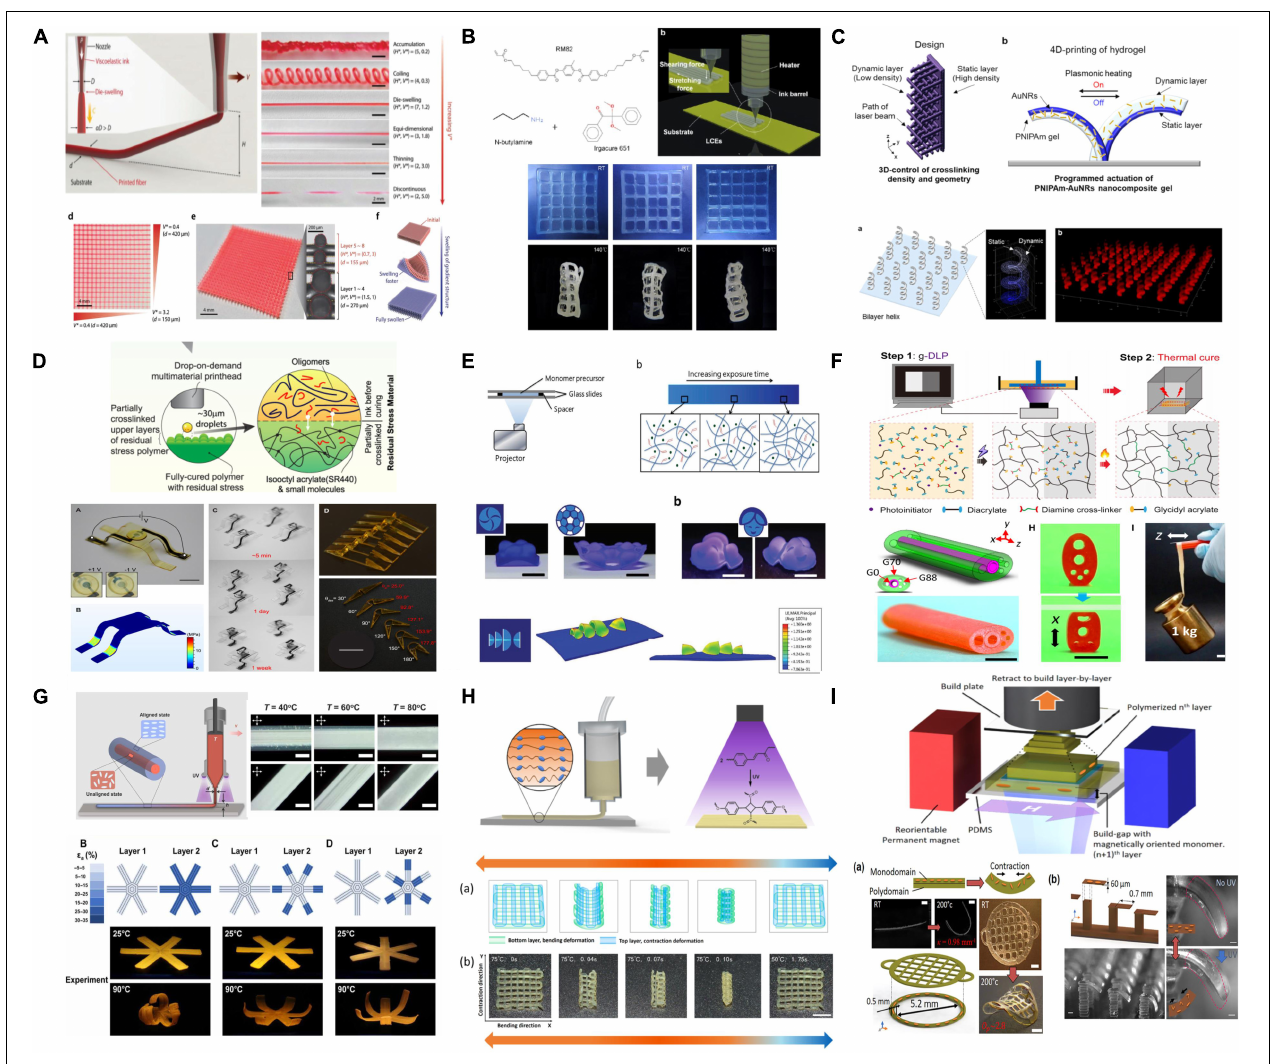
FIGURE 6 | The soft actuators mimicking the designs of plants by regulating the parameters in 4D printing process. (A) Gradient swelling soft actuator by varying the moving speed and the printing height. (B) Shape morphologies and motions of the LCEs by locally adjusting the print speed and print path during 3D printing. (C) Bioinspired soft actuator with programmed printing density by tuning the writing distance in multiphoton lithography process. (D) Self-folding electronics by locally engineered stress generated between the upper and lower layers in the drop-on demand multimaterial 3D printing process. (E) Differential expansion of polymer networks by varying the degree of cross-linking density of pixelated polymers. (F) Mechanically graded and glass transition temperature-graded materials by tailored grayscale digital light patterns. (G) Actuation and mechanical properties of LCE filaments by varying printing parameters (printing temperature, nozzle size, and distance between the nozzle and build plate). (H) Shape-morphing of the orientated gradient liquid crystal polymer by the temperature gradient between the two sides of printed samples. (I) Liquid crystalline polymers with molecular orientation defined by the combination of a reorientable magnetic field and spatially selective